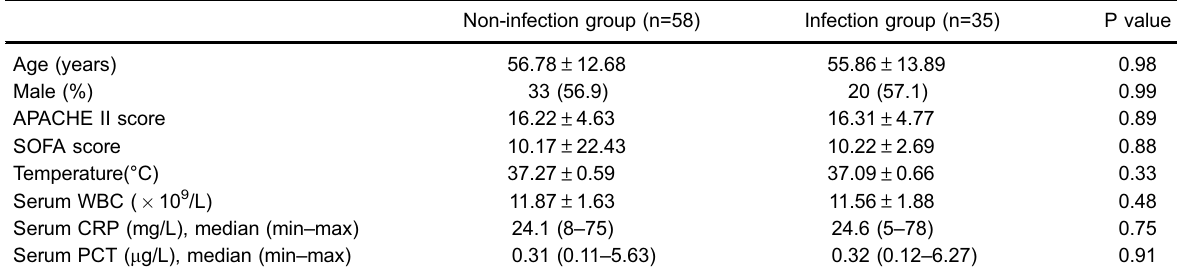
Table 1. Characteristics of the 2 groups at